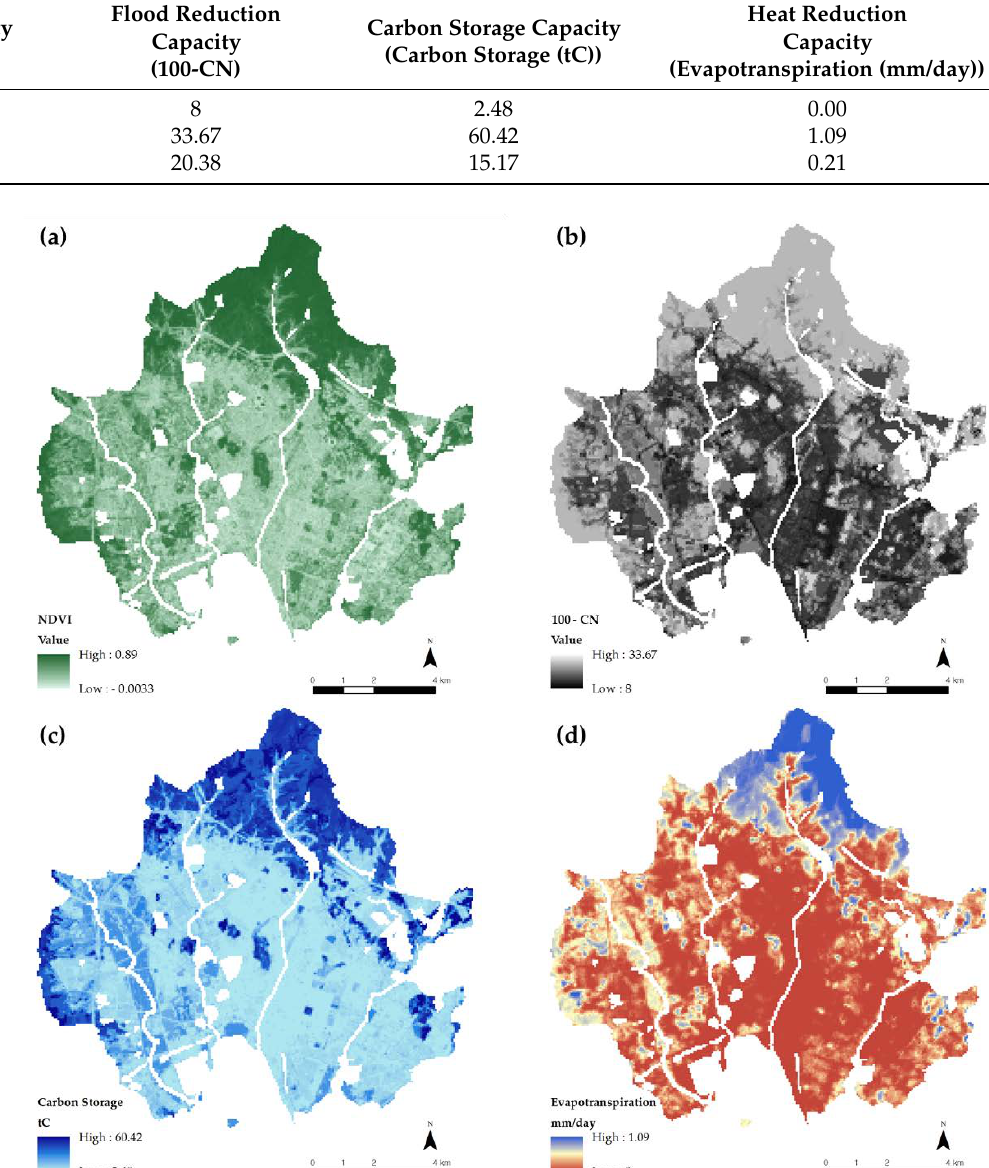
Table 3. Descriptive statistics of ERS.